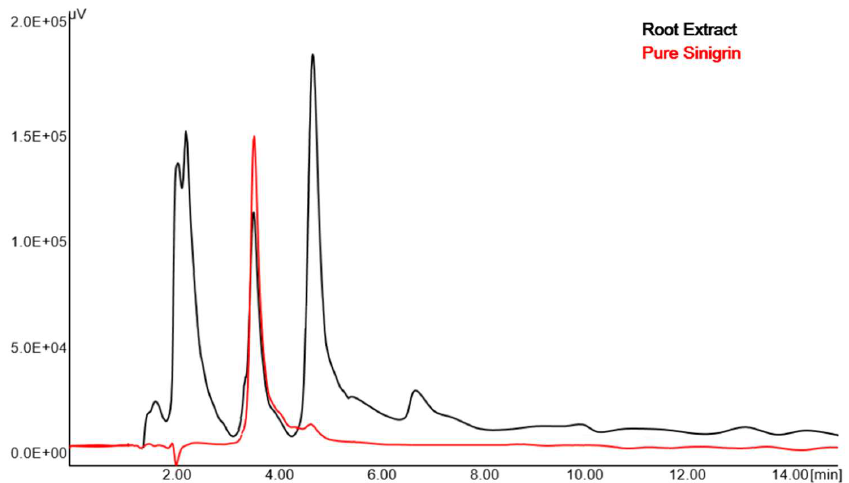
Figure 3. Overlay of chromatogram of prepared fraction of Raphanus sativus roots and pure sinigrin at 227 nm.